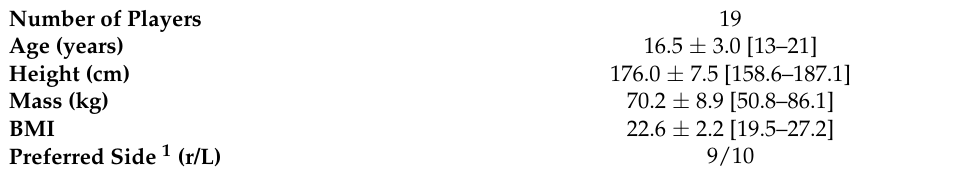
Table 1. Demographic data, mean ± SD